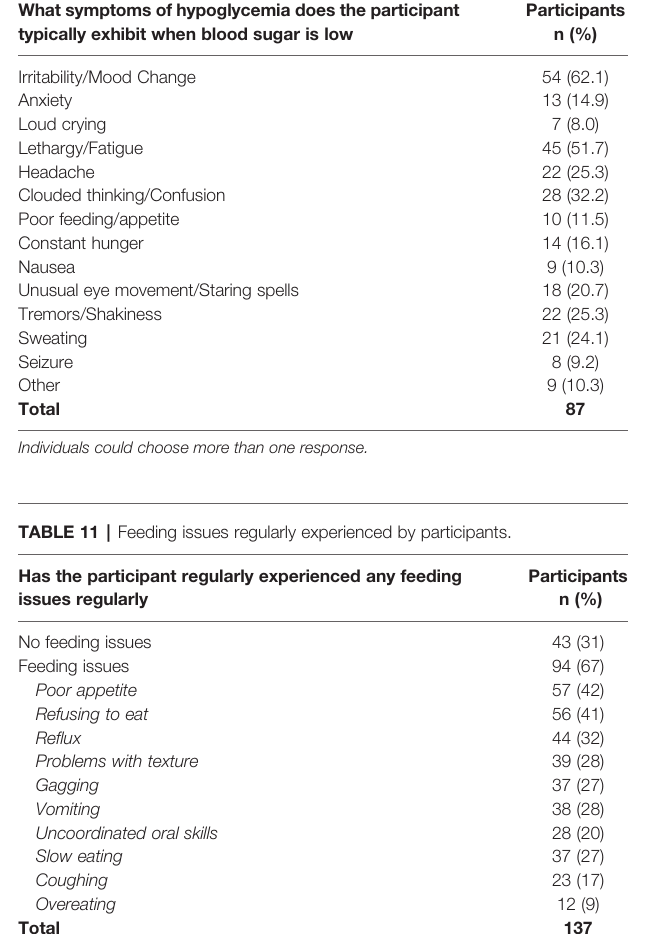
TABLE 10 | Reported symptoms of hypoglycemia the participant exhibits when blood sugar is low. What symptoms of hypoglycemia does the participant typically exhibit when blood sugar is